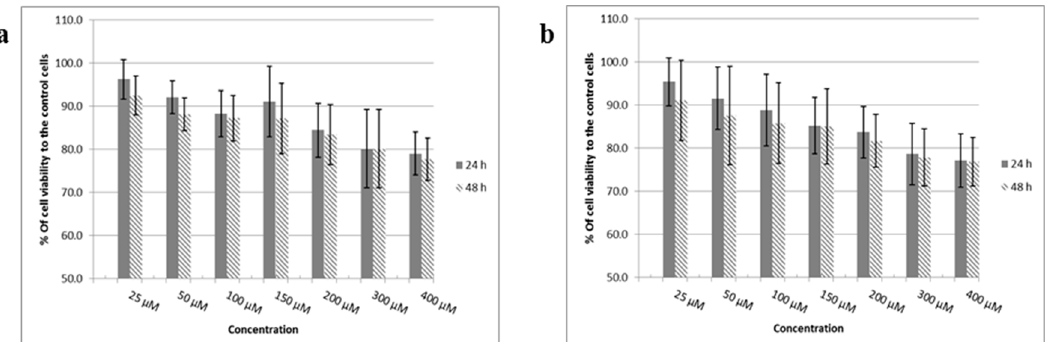
Figure 3. MTT (1-(4,5-Dimethylthiazol-2-yl)-3,5-diphenylformazan thiazolyl blue tetrazolium) results after 24 and 48 h treatment of bEnd.3 cells with: ( a ) G0K-FP and ( b ) G1K-FP. The absorbance was measured and the cell viability was calculated as a percentage of absorbance in relation to control cells. The data represent mean ± SD (standard deviation) of n = 6.